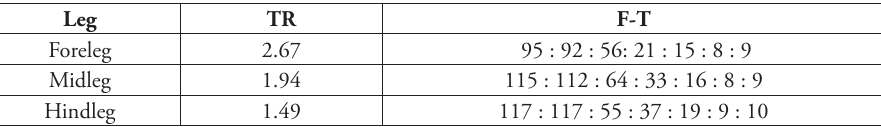
Fig. 1b, wing length 1.58 (n = 1), width 0.55 (n = 1); CR 0.57 (n = 1). TR and F-T of legs